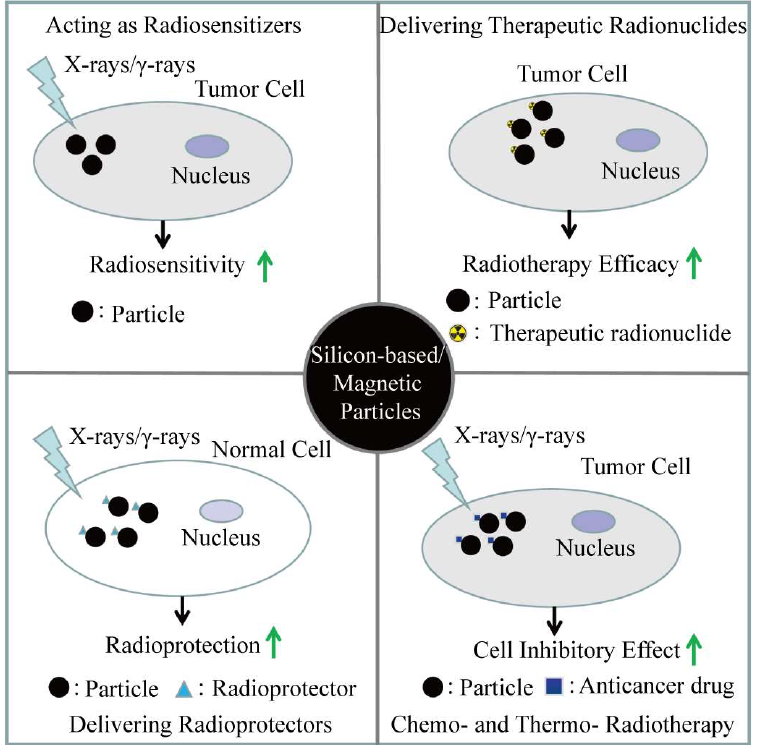
Figure 2. Applications of particles in radiotherapy. The particles mainly include silica-based and magnetic particles, and they can act as radiosensitizers, deliver therapeutic radionuclides and radi- oprotectors, and be applied in synergistic treatment.